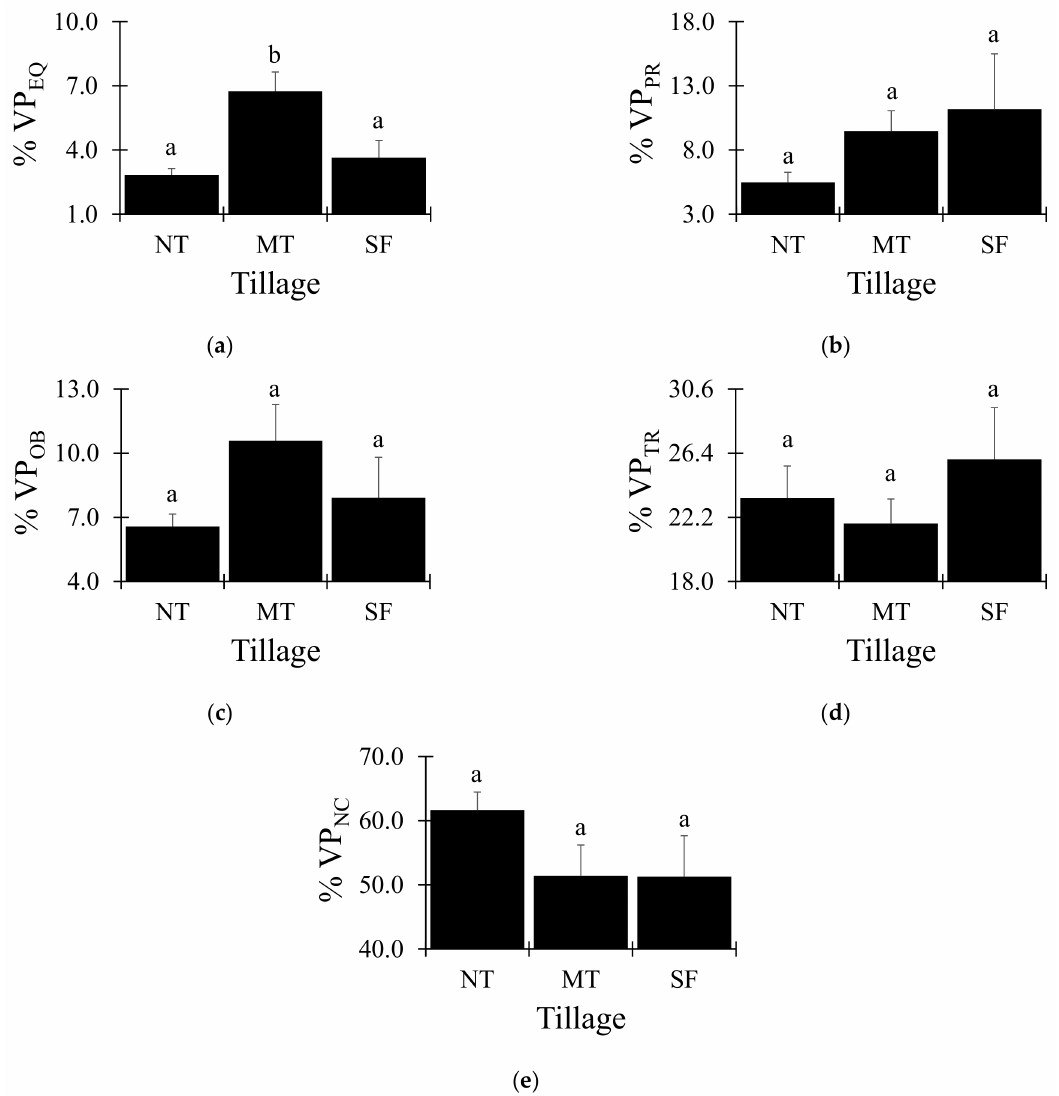
Figure 5. Pore shape distributions within the following classes: ( a ) equant (EQ), ( b ) prolate (PR), ( c ) oblate (OB), ( d ) triaxial (TR), and ( e ) non classified (NC) for soil aggregates from no tillage (NT), minimum tillage (MT), and secondary forest (SF). Vertical bars represent the standard error ( n = 6). Different letters represent significant differences among management practices (Tukey’s HSD; p <